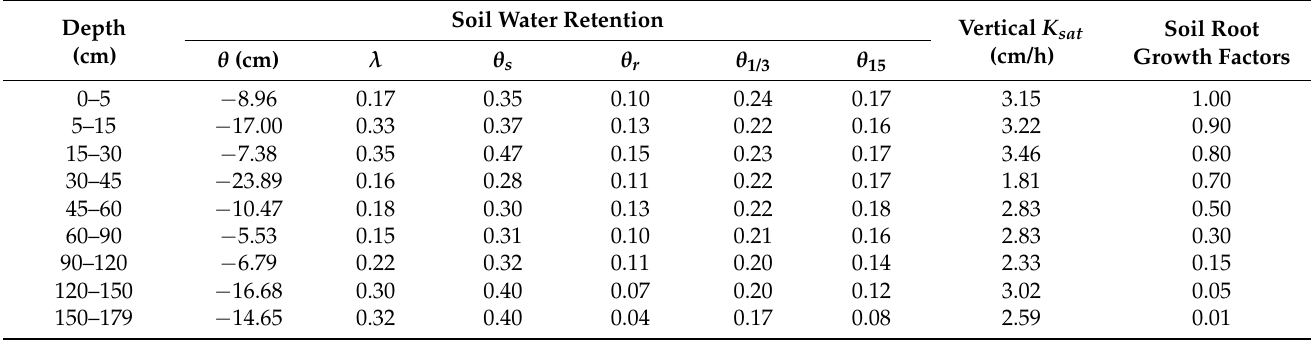
Table 2. Calibrated RZWQM2 soil hydraulic parameters for the experimental sites.